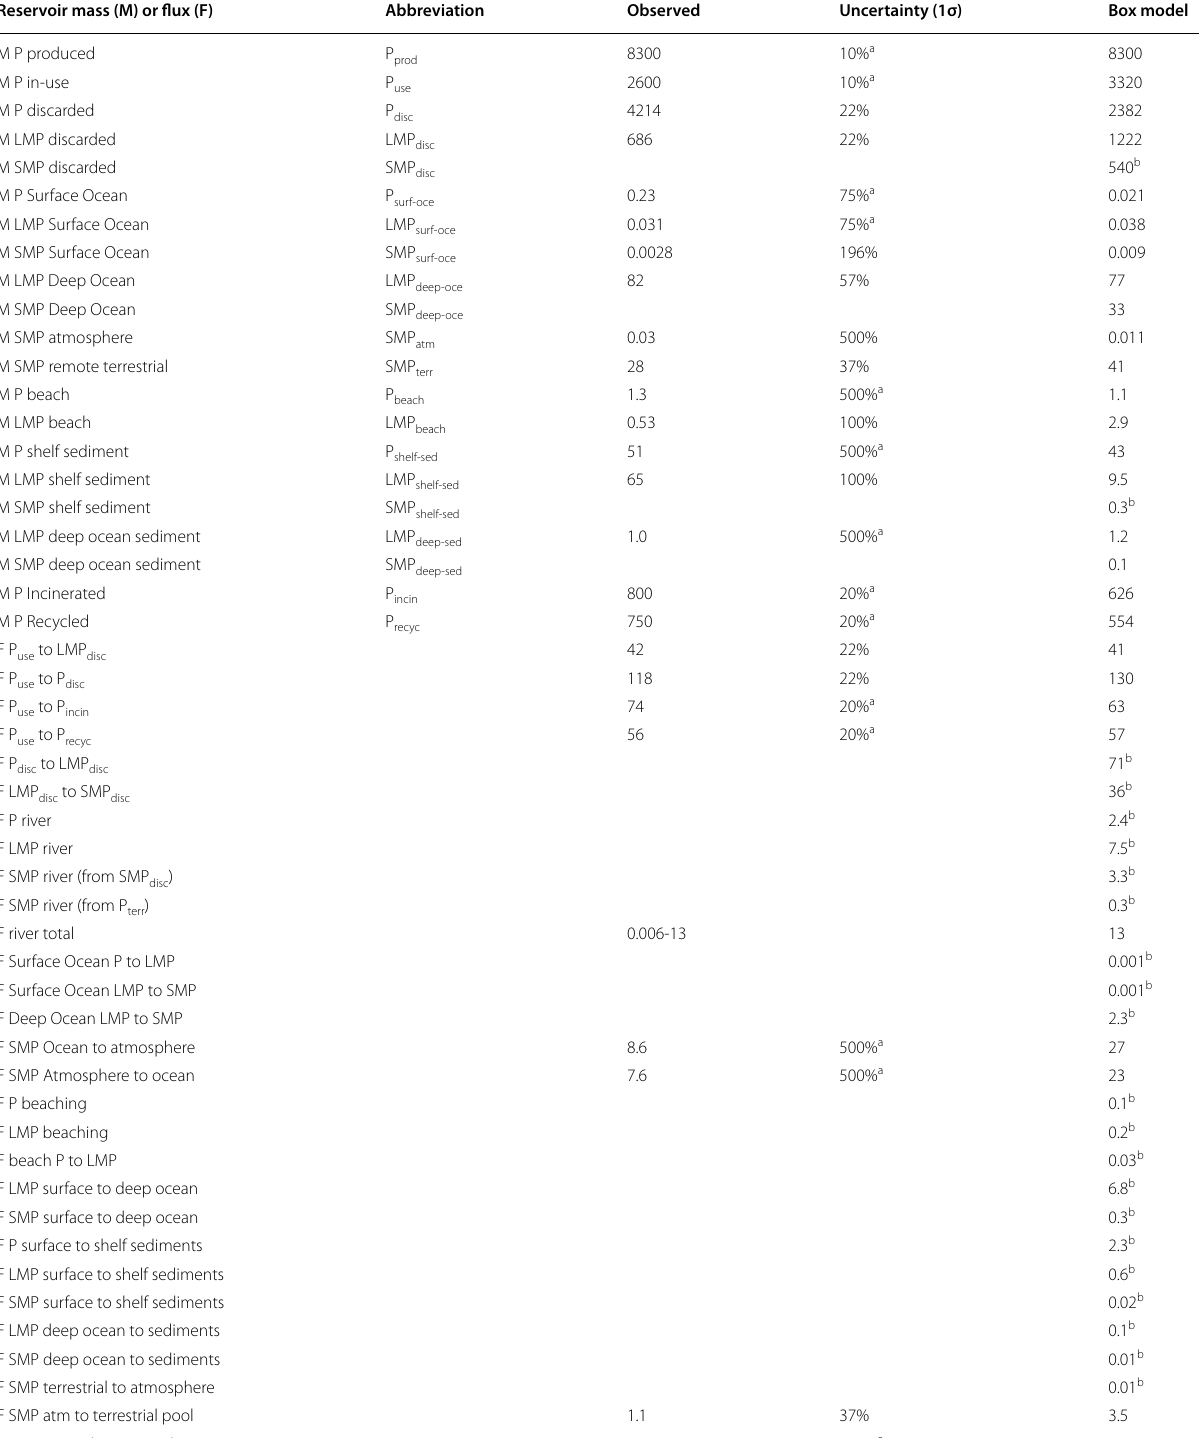
Table 4 Comparison of observed and modeled plastics mass (M, in Tg) and fluxes (F, in Tg y − 1 ) for the year 2015 Reservoir mass (M) or flux